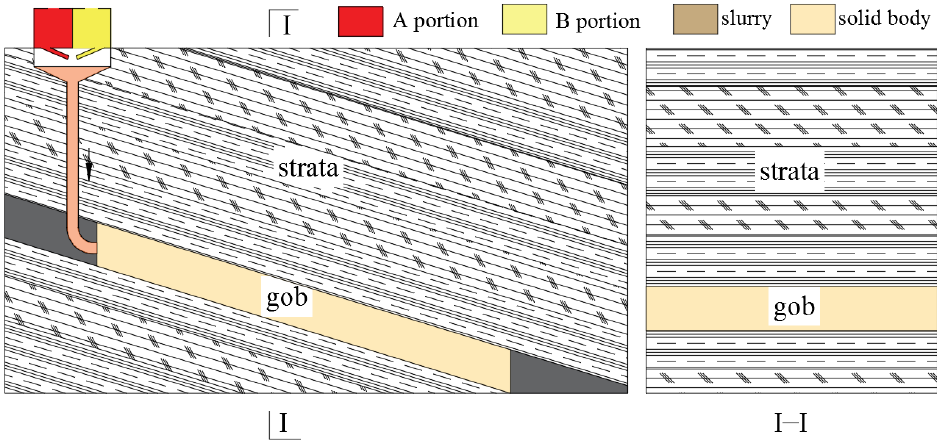
Figure 19. High-water backfill mining